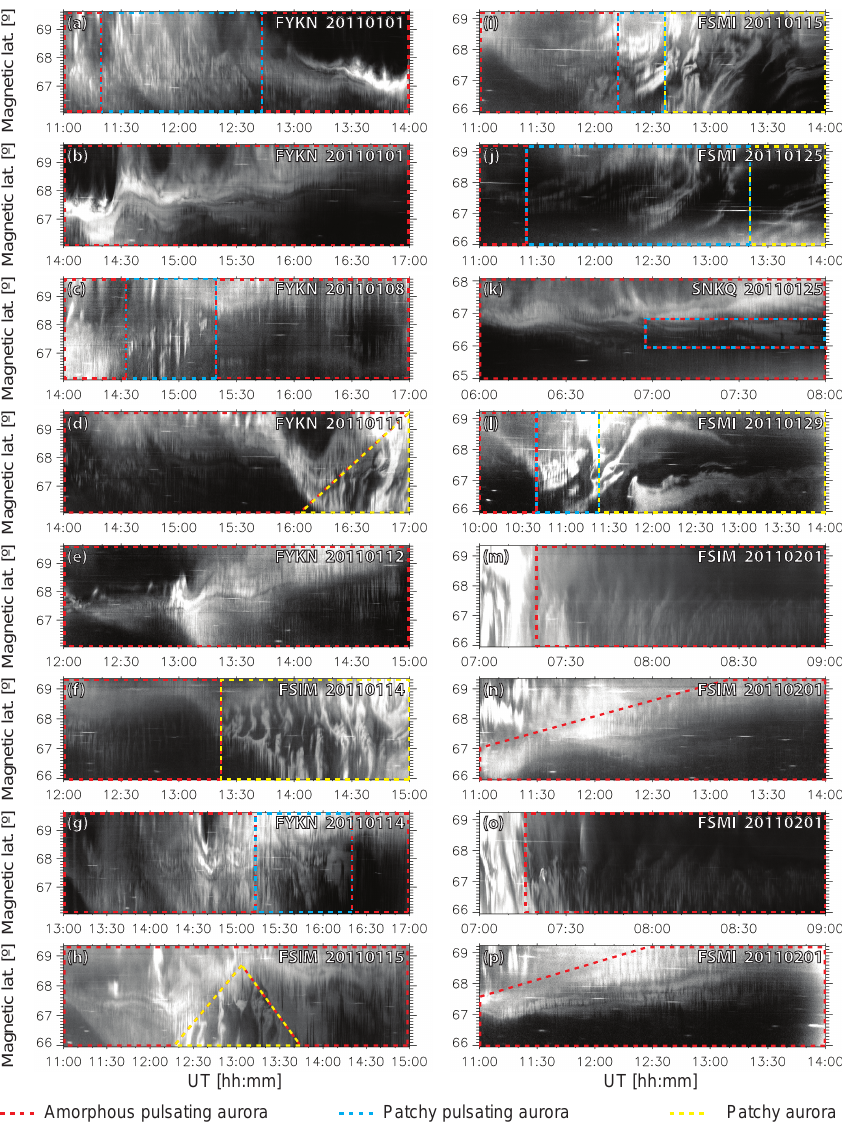
Figure 3. Sixteen pulsating aurora events where regions of amorphous pulsating aurora, patchy pulsating aurora, and patchy aurora are approximately outlined in red, blue, and yellow, respectively. The outlined regions designate only the most prominent types in the keogram and do not imply that no other types are simultaneously present within the ASI field-of-view. Videos of the associated ASI data are included in Grono